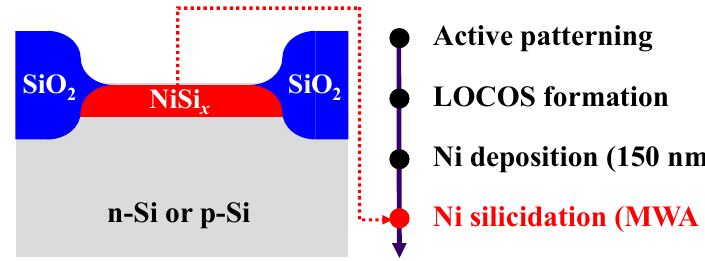
Figure 2. The schematic structure and process flow of the NiSi x SB-diodes.